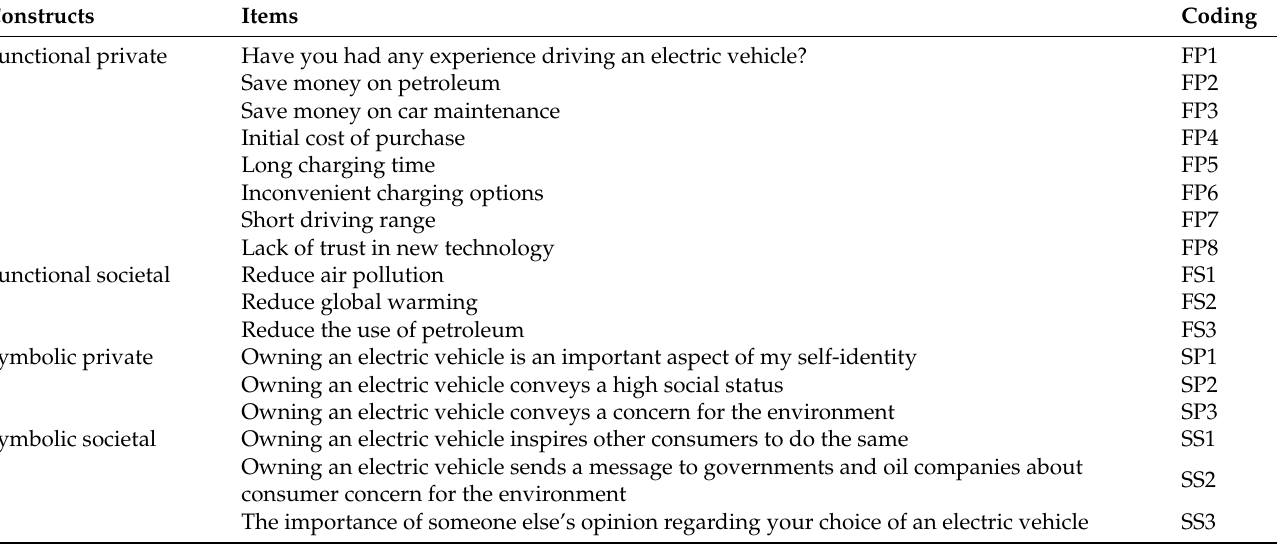
Table 2. Constructs and measurement